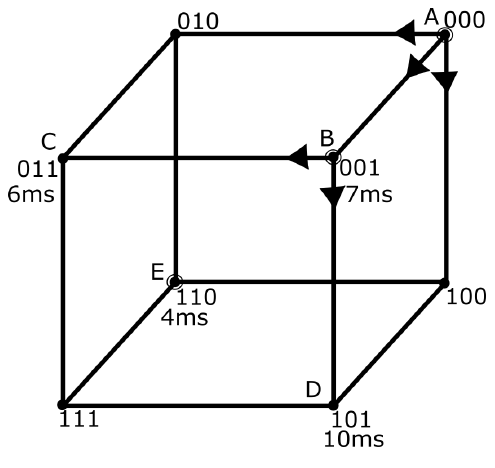
Figure 2. Instance of 3-D Hypercube and routing presentation